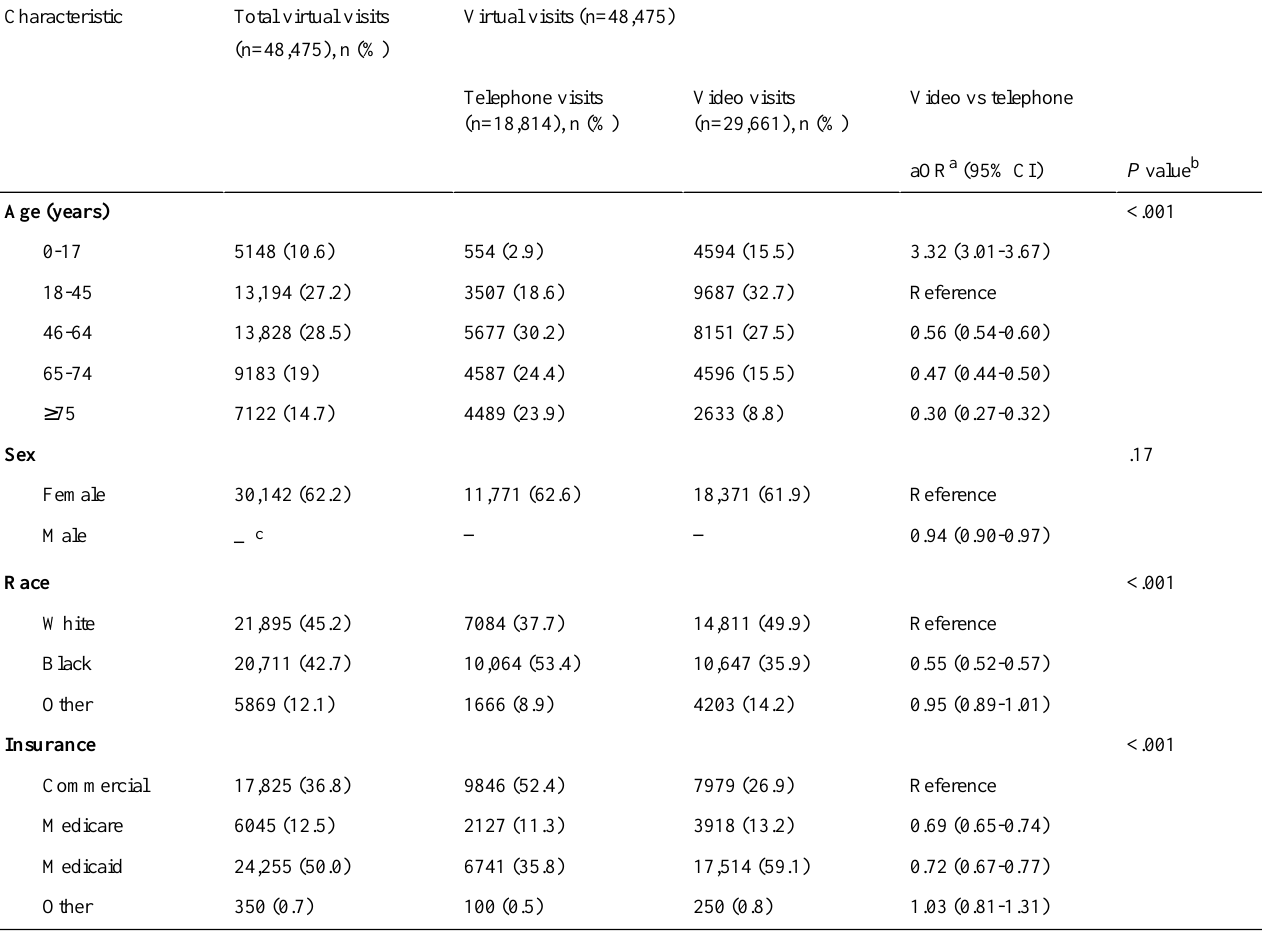
Table 2. Associations between patient sociodemographics and type of virtual visit from March 15 to May 31, 2020.